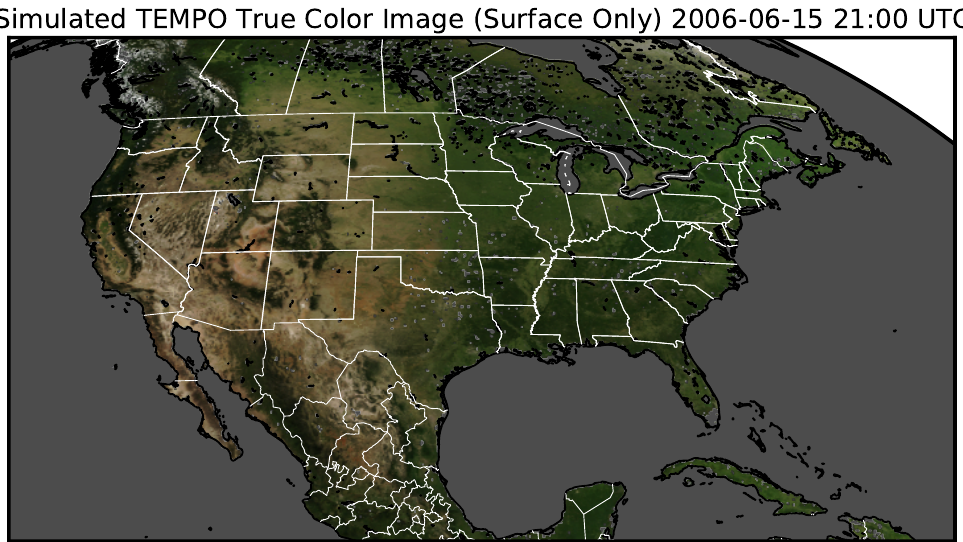
Figure 10. Simulated true color image for 15 June 2006 21 UTC in the G5NR simulation as would be observed by TEMPO. The images were created by combining the simulated TOA reflectance at 470, 550, and 670 nm. The top image includes surface reflectance as well as atmospheric scattering from molecules, aerosols, and clouds. The bottom image shows surface reflectance alone.